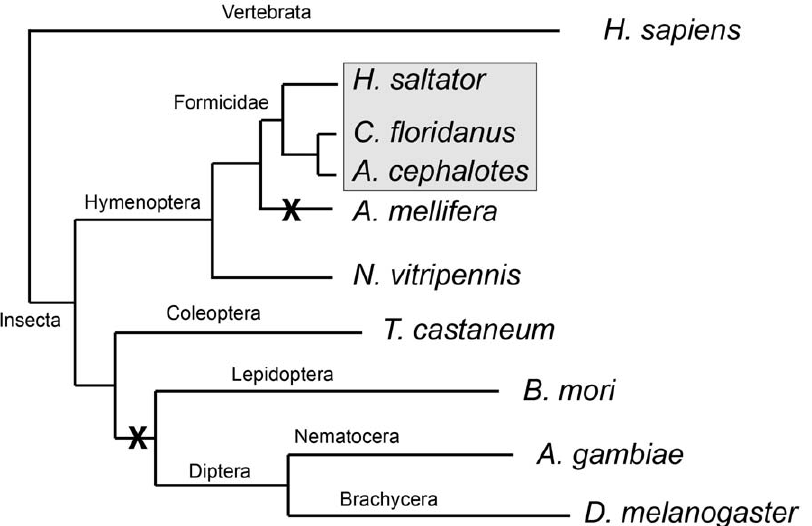
Figure 5. Phylogenetic relationship of selected ant and insect species. The phylogenetic relationship of the ant species (Formicidae) used for this study ( Atta cephalotes , Camponotus floridanus and Harpegnathos saltator ; shown as grey box) is indicated as a phylogram tree (adapted and modified from [16,66]) in comparison to two Hymenoptera species Apis mellifera (honeybee) and Nasonia vitripennis (parasitoid wasp), the Coleoptera species Tribolium castaneum (red flour beetle), the Nematocera species Anopheles gambiae (mosquitoes), the Brachycera species Drosophila melanogaster (fruit fly) and human as representative vertebra species ( Homo sapiens ). The absence of the oxytocin/vasopressin peptide hormone system in a specific lineage is indicated with an